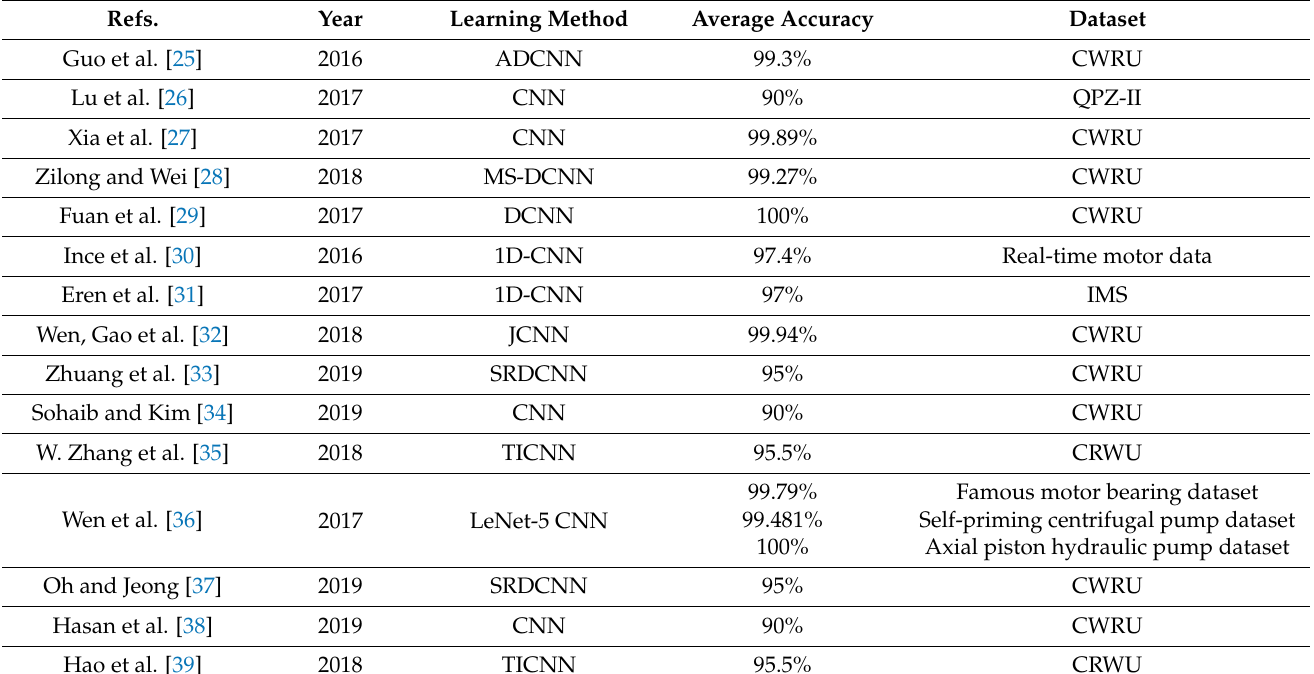
Table 4. CNN methods used for fault bearing diagnosis research